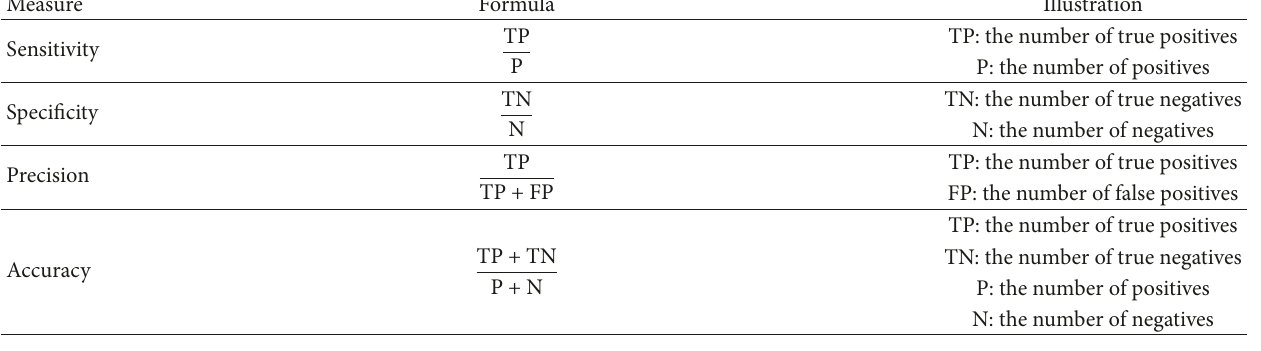
Table 7: The definition of the classification measurement.